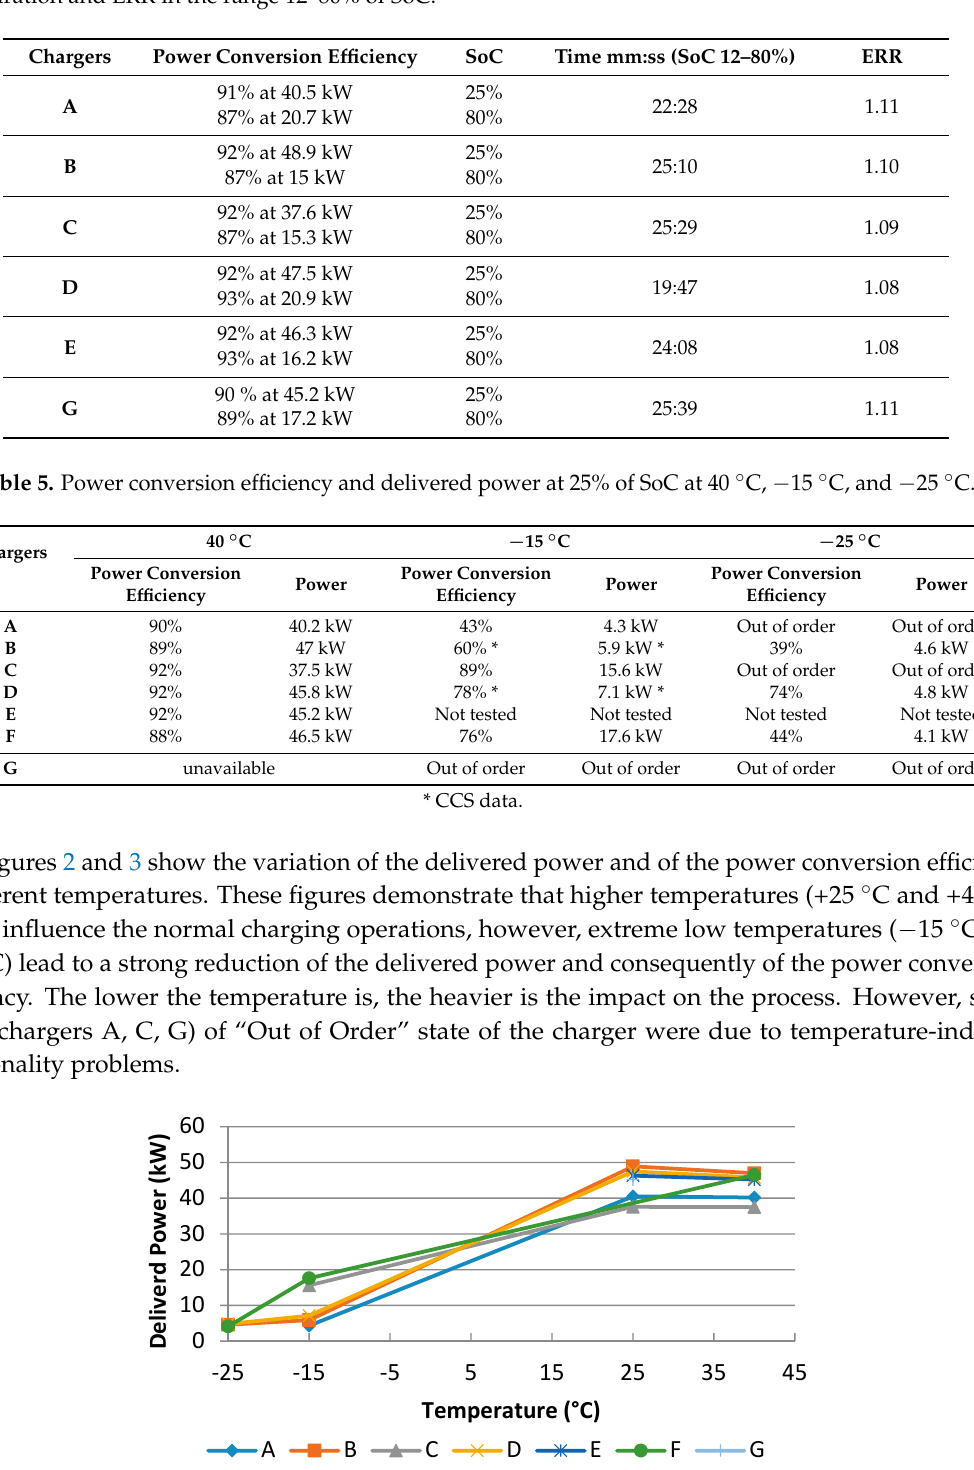
Table 4. Recharge at 25 °C: Power conversion efficiency at 25% and 80% of SoC (state of charge), duration and ERR in the range 12–80% of SoC.